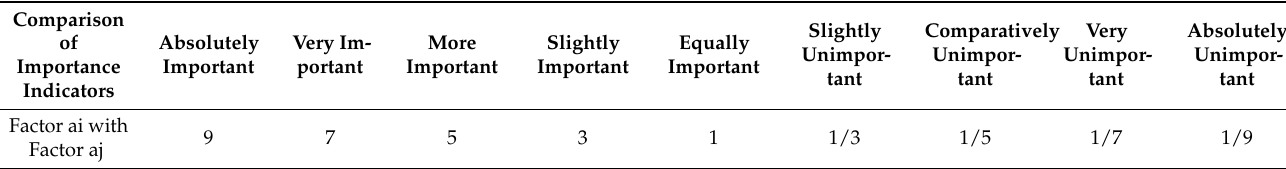
Table 2. The contrast degree of the